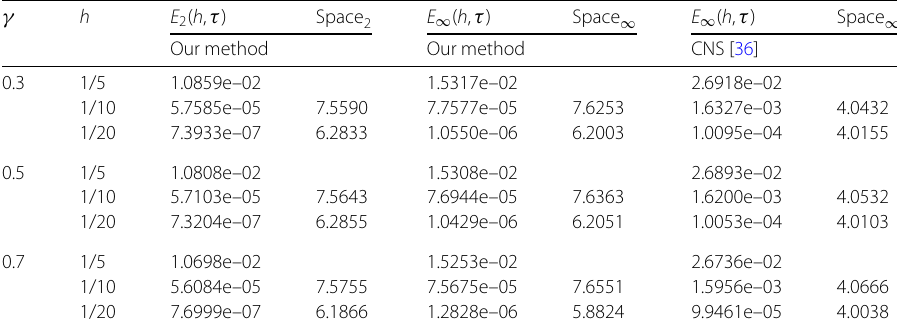
Table 5 (Example 6.2) E 2 ( h , τ ), E ∞ ( h , τ ) and spatial convergence orders